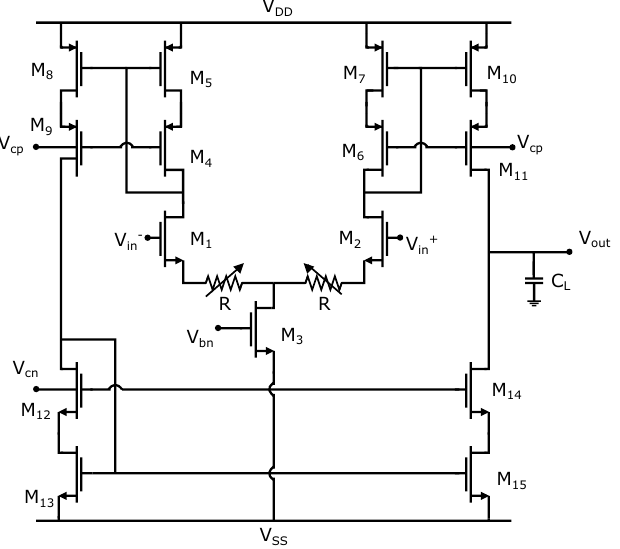
Figure 10. CMOS OTA taken from [36].